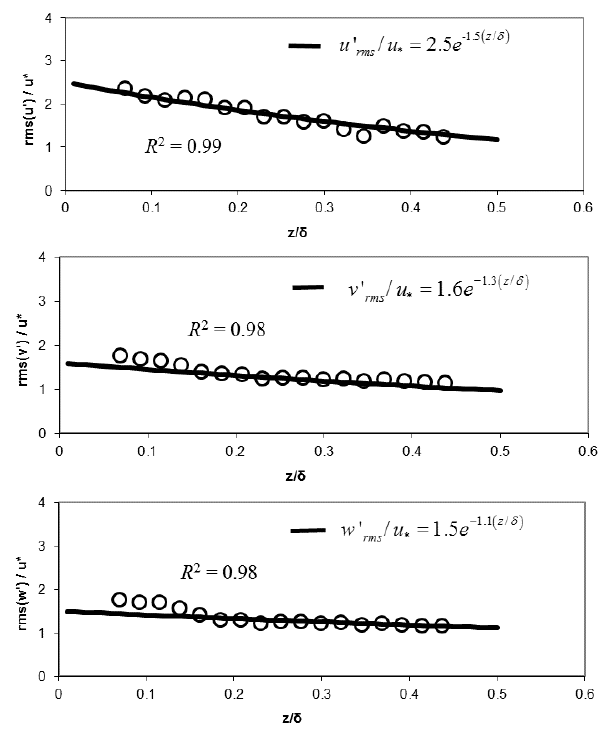
Figure 4. Measured normalised turbulence intensity profiles for smooth bed flow (Test 1).